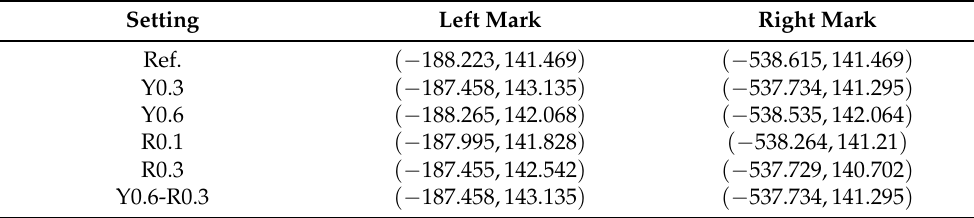
Table 3. The positions of the left and the right mark (unit:mm). Setting Left Mark Right Mark Ref.